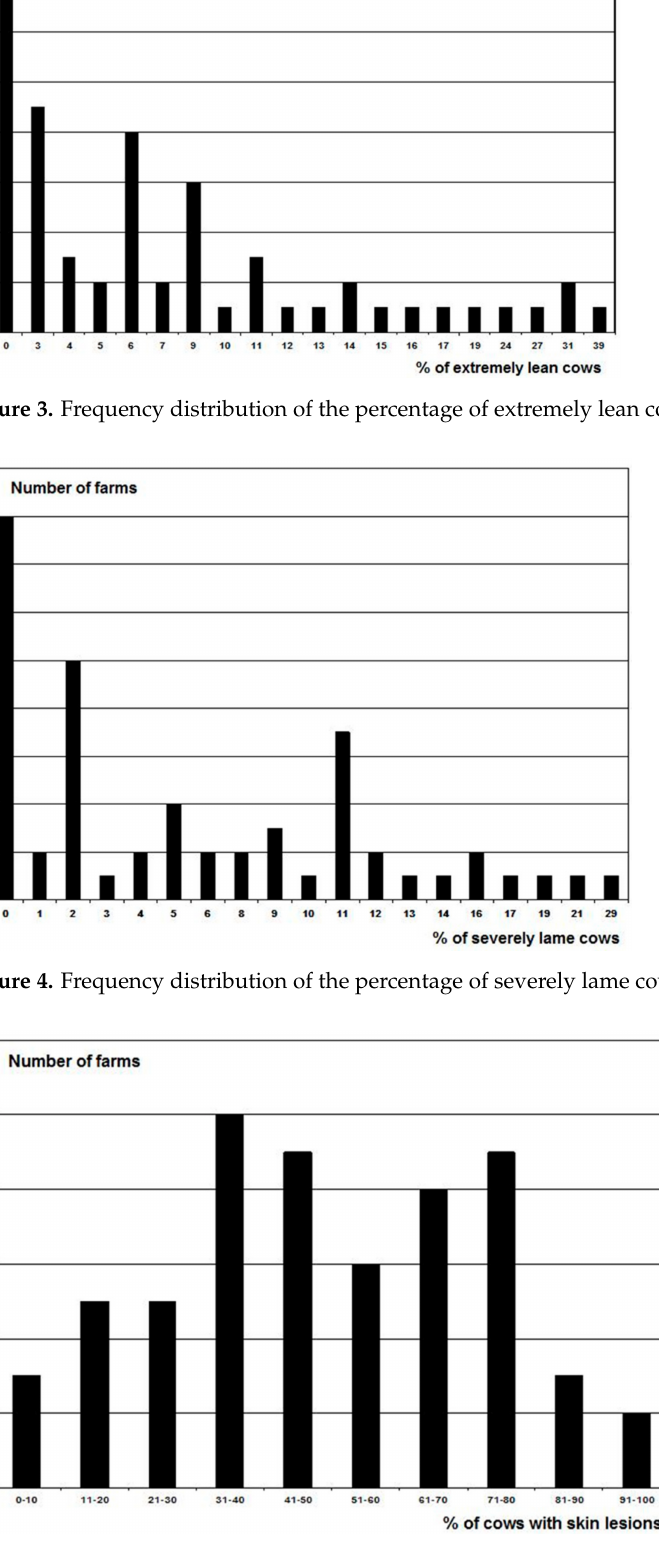
Figure 5. Frequency distribution of the percentage of cows with at least one skin lesion on the 60